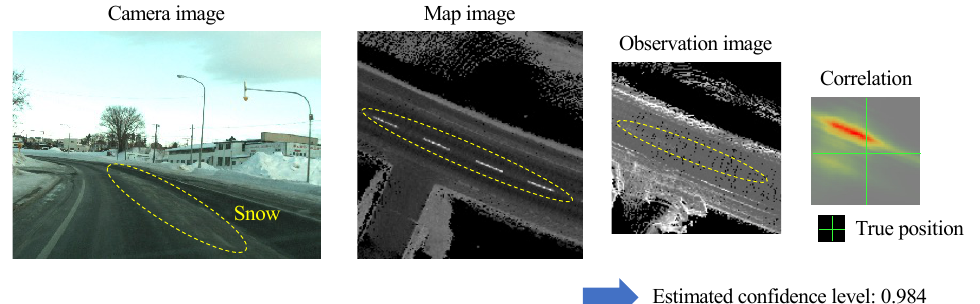
Figure 18. Example of incorrect confidence estimation. The area corresponding to the snow-covered region shown in the camera image is circled by a dotted line on the map and observed images. The peak of the correlation is at a different location from the true position, but a very high confidence level of 0.984 is estimated.